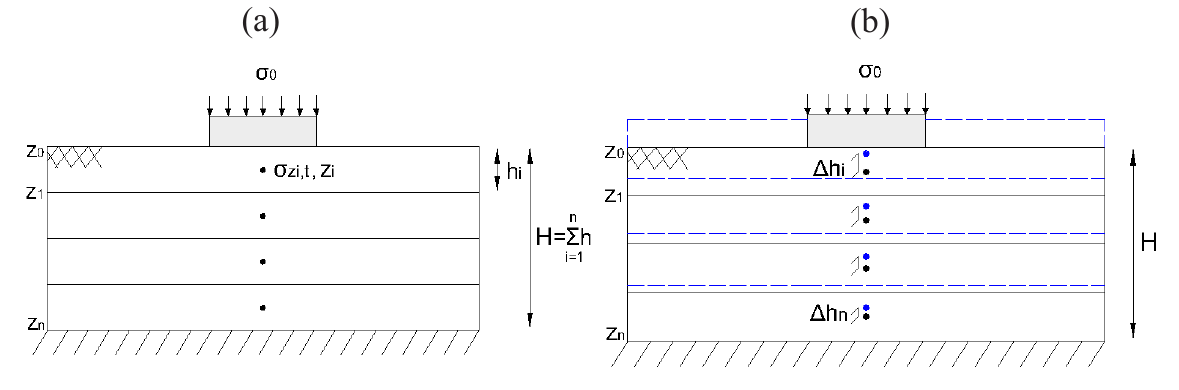
Figure 5: (a) Initial states of layers, (b) Final states of layers after total heave